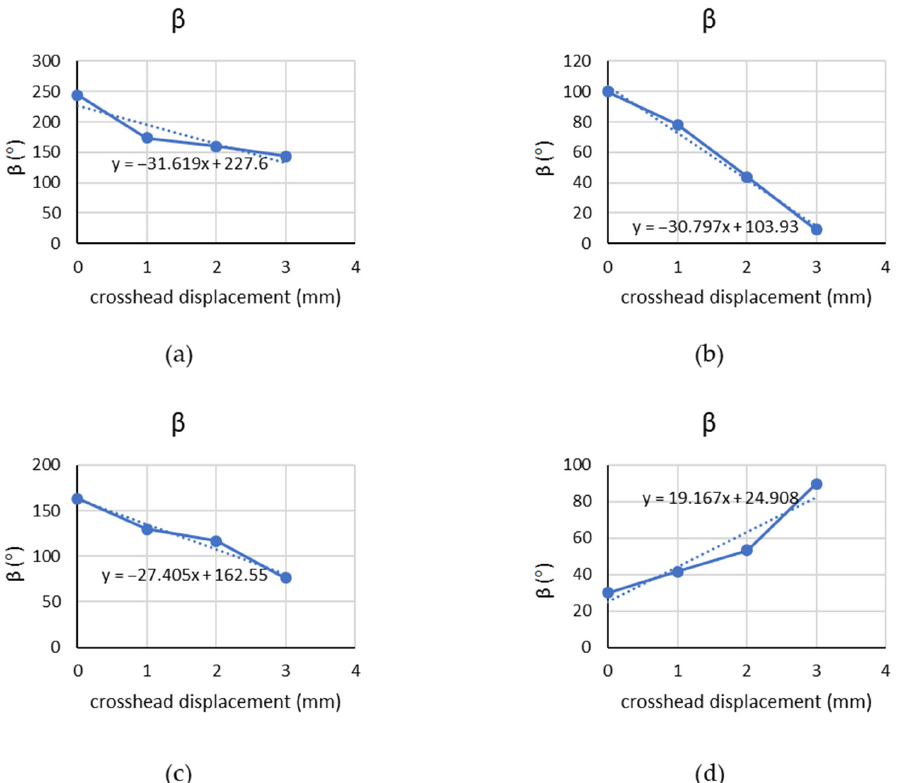
Figure 15. Optical measurement results of the biological tissue tensile experiment for ( a ) the first slice, ( b ) the second slice, ( c ) the third slice, and ( d ) the fourth slice.